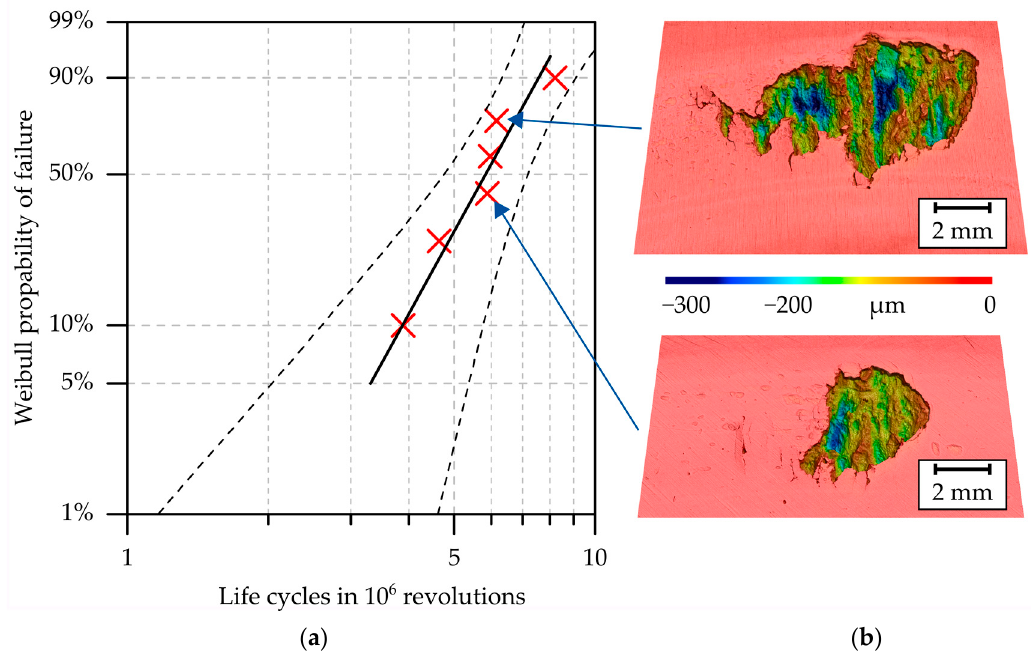
Figure 14. Bearing fatigue testing results: ( a ) Weibull plot with 95% confidence band for AISI 52100 tailored forming washers; ( b ) fatigue damage analysis by laser-scanning microscopy (rolling direction: right to left).